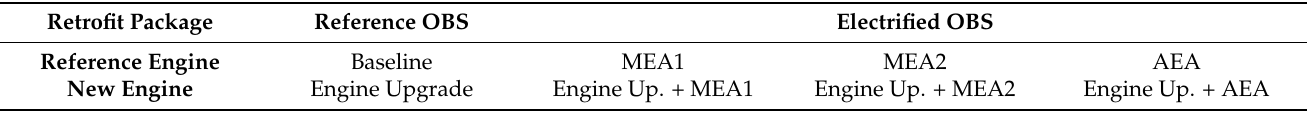
Table 3. The retrofit solution, considered for cost analysis.